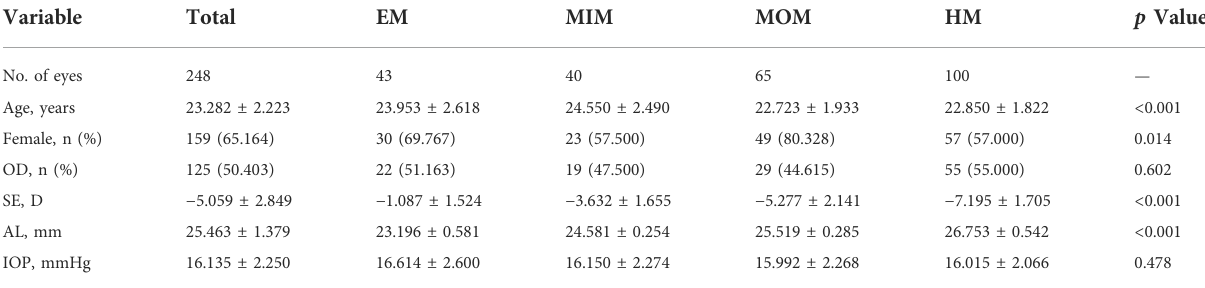
TABLE 1 Demographic features of the enrolled